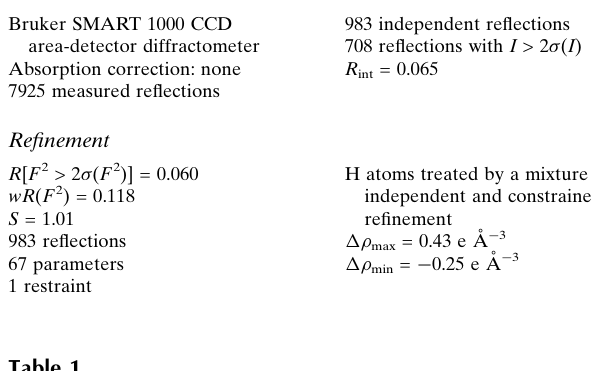
Hydrogen-bond geometry (A˚ , (cid:4)